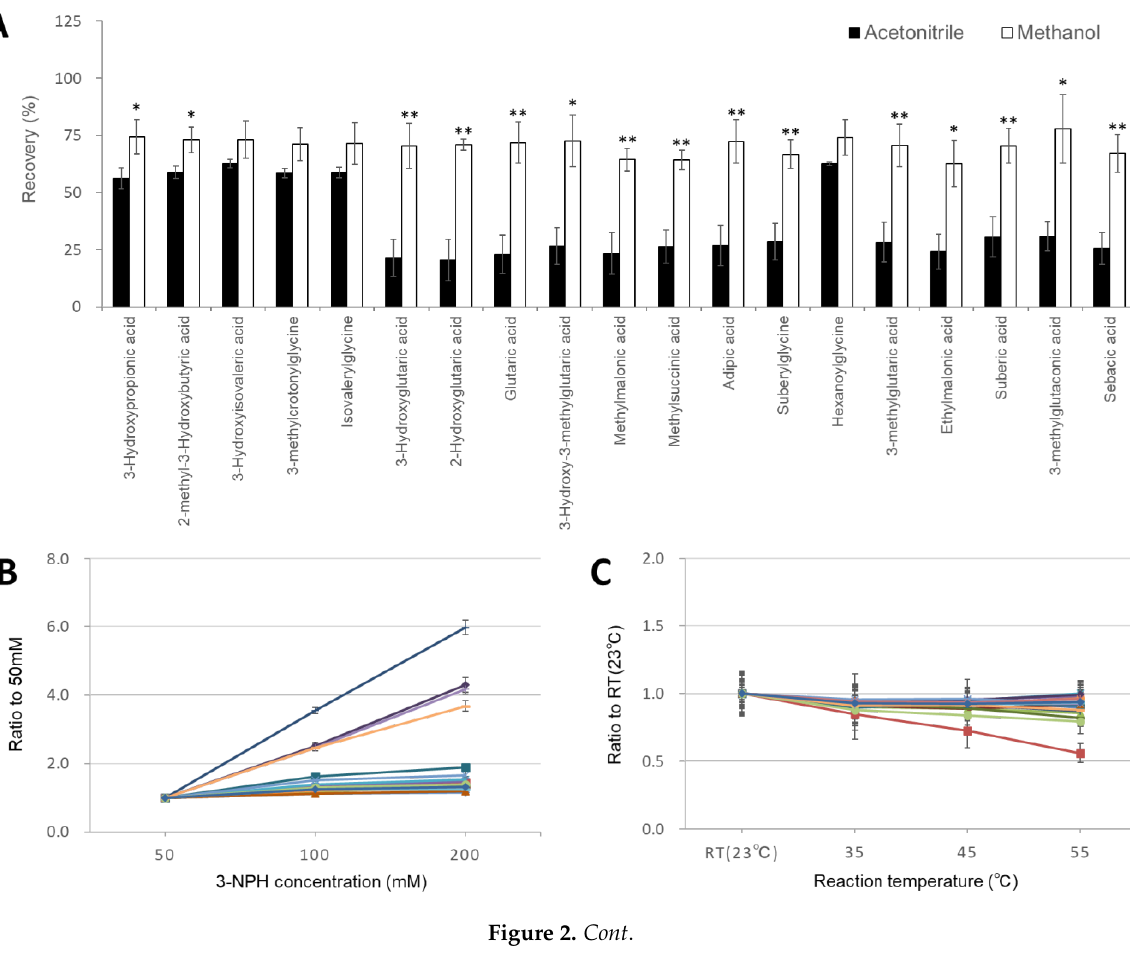
Figure 2. Investigation of sample pretreatment conditions. ( A ) Investigation of organic acid extraction solvent. Recovery rate in serum samples spiked with analytes ( n = 3 per group). Data represents means ± SD. * p value < 0.05, ** p value < 0.01 versus Acetonitrile. Effect of 3-NPH derivatization reaction by ( B ) 3-NPH concentration, ( C ) reaction temperature, and ( D ) reaction time. Data represents means ± SD. 3.4. Optimization of the 3-NPH Derivatization Reaction We optimized the conditions of 3-NPH derivatization, including the concentration of 3-NPH (50 to 200 mM), reaction temperature, and reaction time. The optimal 3-NPH con- centration was determined to be 200 mM as it was the maximum concentration that could be stably prepared (Figure 2B). Next, the reaction temperatures of the individual peak areas were examined ranging from RT to 55 °C. For most organic acids, the reaction tem- perature did not significantly affect the signal intensities, except for that of the 2-methyl- 3-hydroxy butyric acid, which showed a clear decrease in the peak area at high tempera- ture. Therefore, the reaction temperature was maintained at 23 °C (Figure 2C). Finally, the reaction time was examined from 5 – 30 min. Most organic acids showed the same signal intensity for reactions proceeding for 30 min as that of the reaction proceeding for 15 min (Figure 2D). Therefore, the reaction time was set to 15 min to complete the sample pre- treatment in a time period close to the sample injection interval of 29 min for LC-MS/MS analysis (Figure 3).